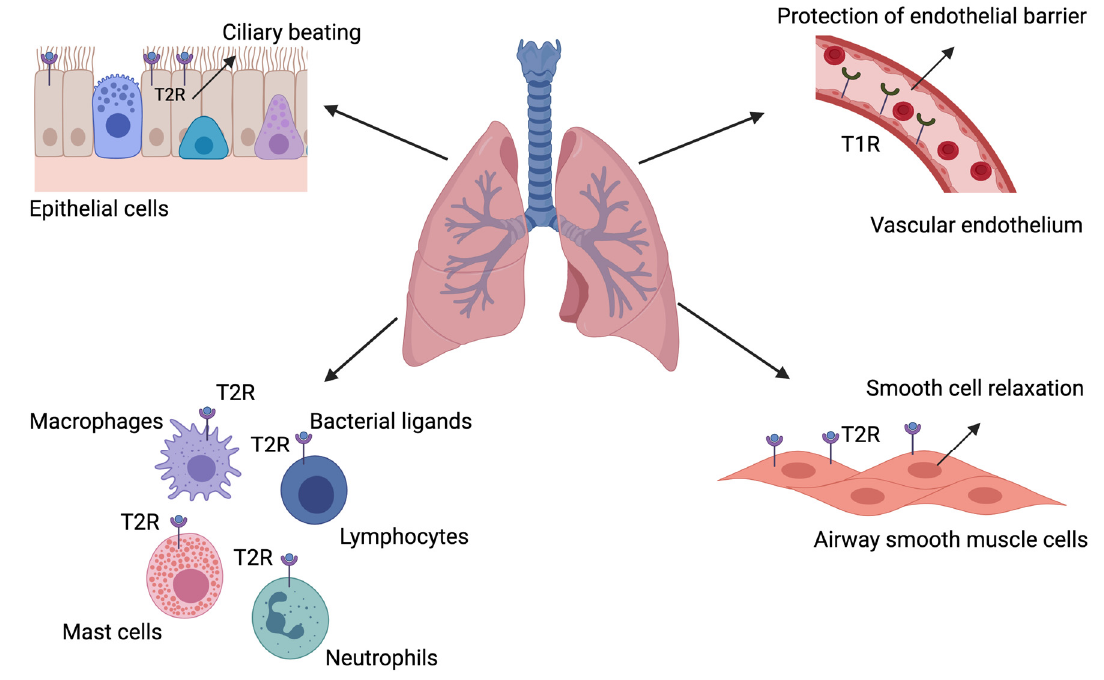
Figure 2. The role of taste receptors in the lower airways. T2Rs are expressed on multiple pulmonary cell types including the airway smooth muscle, epithelial cells, and immune cells (i.e., macrophages, mast cells, lymphocytes, and neutrophils). Activation of T2R on ciliated epithelial cells results in increased ciliary beating, which leads to bacterial clearance. Activation of T2Rs on various immune cells also plays an important role in bacterial clearance by inducing a proper immune response against encountered microbial products. In airway smooth muscle cells, activation of T2Rs results in bronchial smooth muscle cell relaxation. Expression of T1R has also been reported in the pulmonary vasculature. Activation of T1Rs by sweet compounds can play a role in protecting the vasculature endothelial barrier. T2R = bitter taste receptor; T1R = sweet taste receptor. Created with BioRender.com.